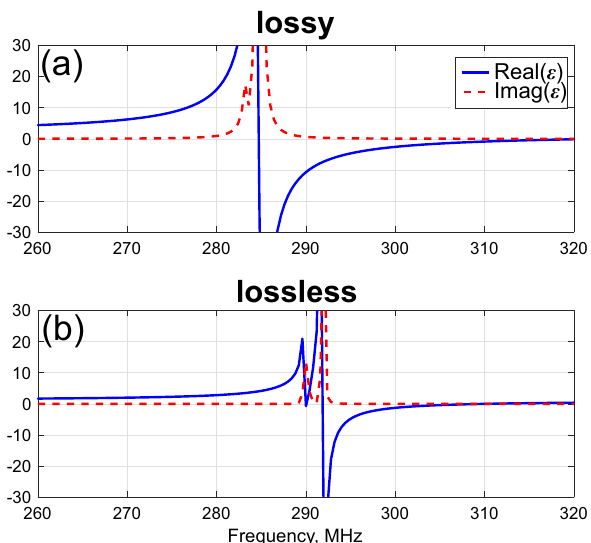
Figure 2. Extracted material parameters dispersion. Effective permittivity component along the direction of the dipoles. ( a ) Lossy and ( b ) lossless (thin wire approximation)